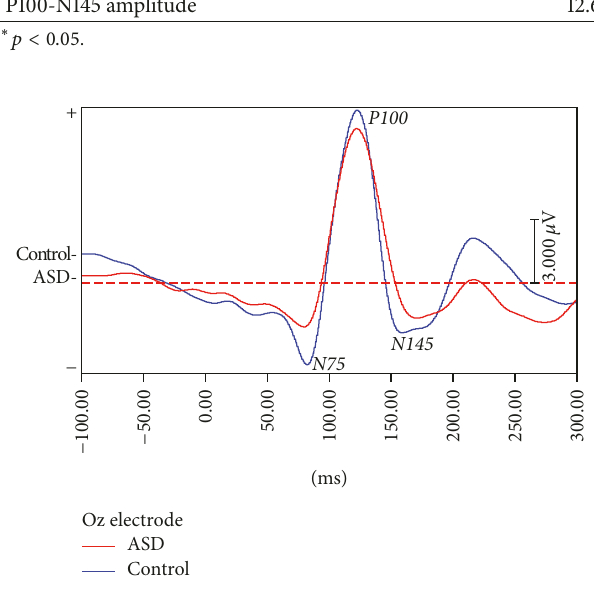
Figure 1: The VEP waveforms over the Oz electrode, a comparison between the ASD and the control groups.